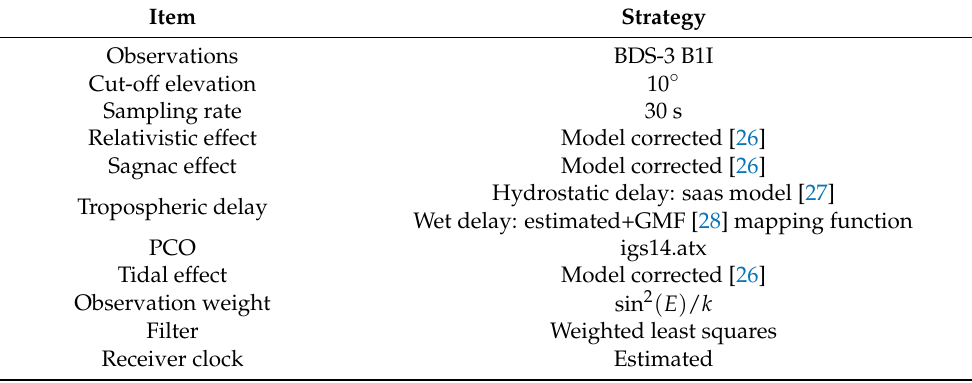
Table 2. Strategies for SF